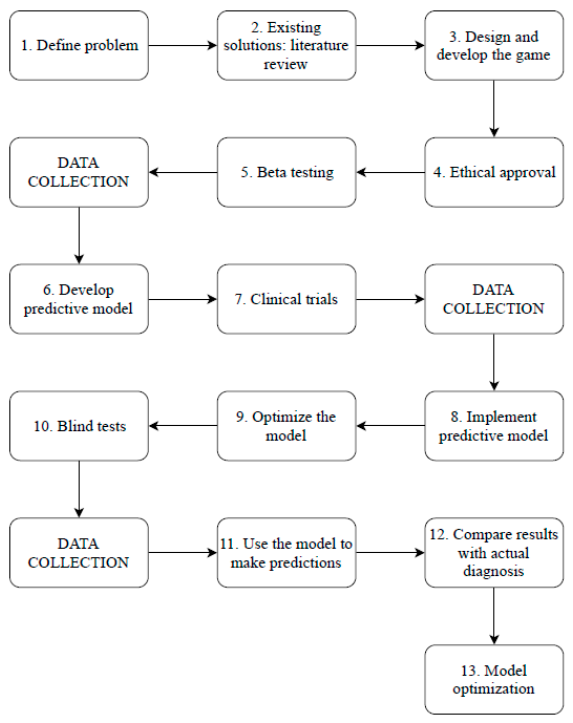
Figure 4. Sequence of Research Activities .